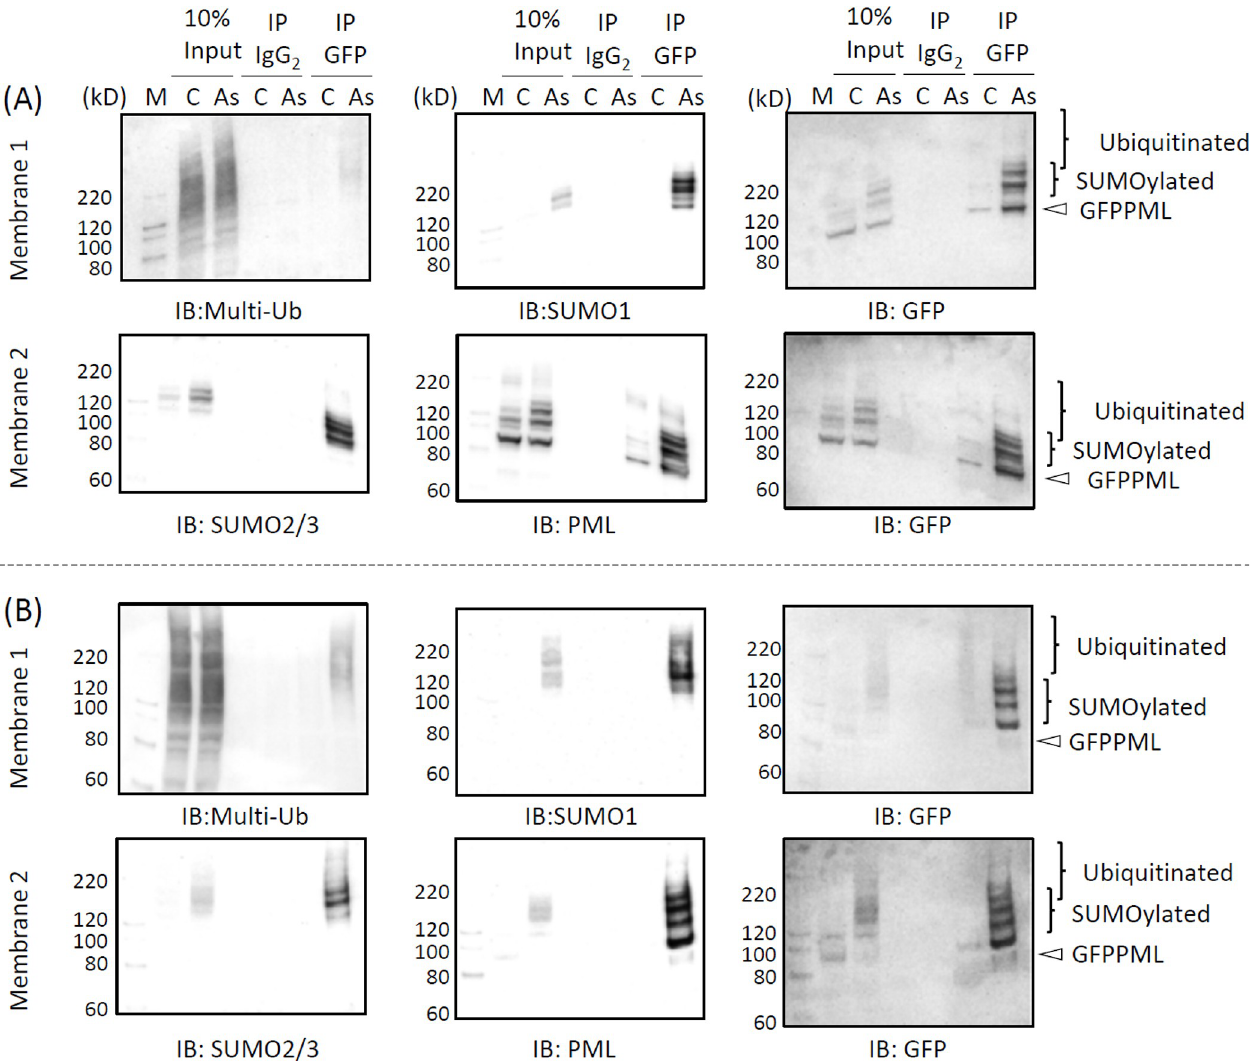
Fig 7. Immunoprecipitation analyses to detect the SUMOylation and ubiquitination of PML in CHOGFPPML (A) and HEKGFPPML cells (B). The cells were exposed to 3 μ M As 3+ (As) or left untreated (C) for 1 h and the RIPA–soluble fractions were collected. The samples were centrifuged again to obtained clear supernatants and subjected to immunoprecipitation with anti–GFP antibody–magnetic beads. The immunoprecipitates were resolved by SDS–PAGE and subsequent western blotting. The membranes were sequentially probed with anti–multi–Ub, anti–SUMO1, and anti–GFP antibodies (membrane 1) or with anti–SUMO2/3, anti–PML, and anti–GFP antibodies (membrane